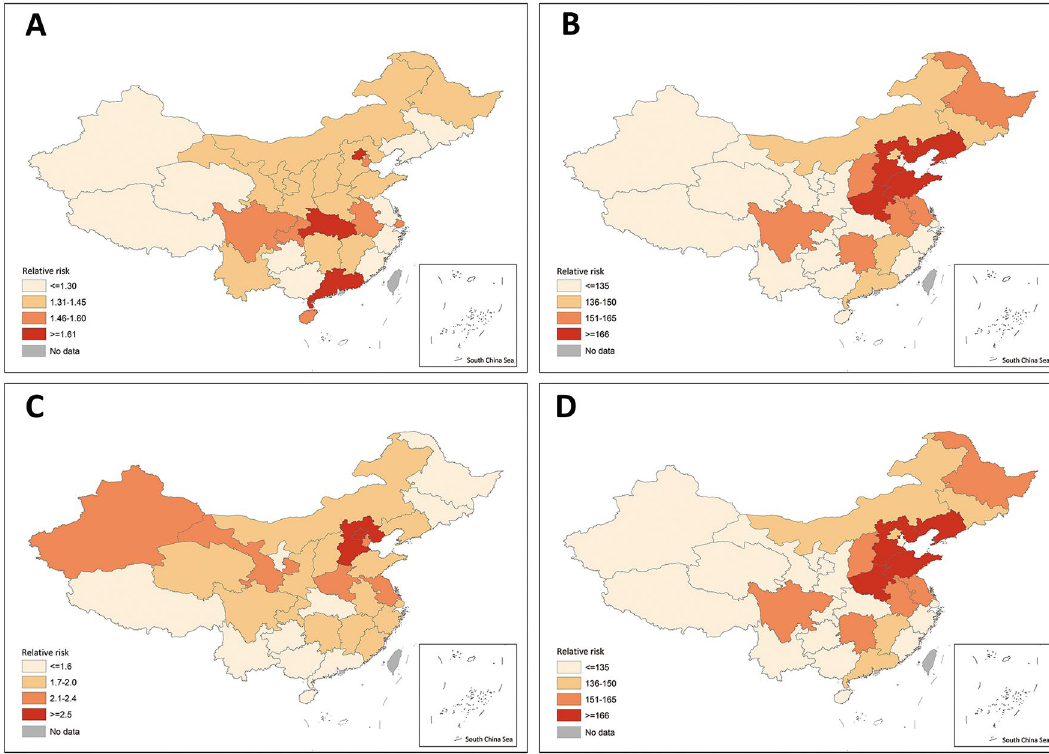
Figure 2. Immediate relative change in search index at different exposure period ( A ) December 31 2019, the estimated start of the first Covid-19 wave. ( B ) 18 January 18 2020 (official announcement of human-to-human transmission) to Jan 25 January 2020 (shortly after the lockdown and the estimated peak of daily search index in the initial Covid-19 wave). ( C ) Outbreak in Beijing starting on June 11 2020. ( D ) Outbreak in Shijiazhuang starting on January 3 2021. Specific point estimate for relative change and the corresponding 95% CIs are provided in the supplemental